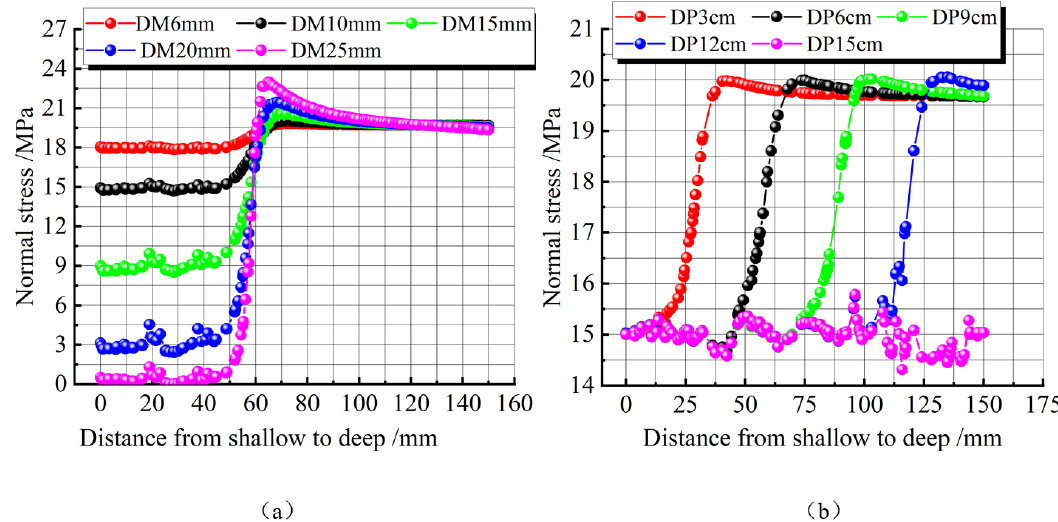
Figure 8. ( a ) is the vertical stress change curve of the monitoring points of different borehole diameter samples from shallow to deep, and ( b ) is the vertical stress change curve of the monitoring points of different borehole depth samples from shallow to deep.